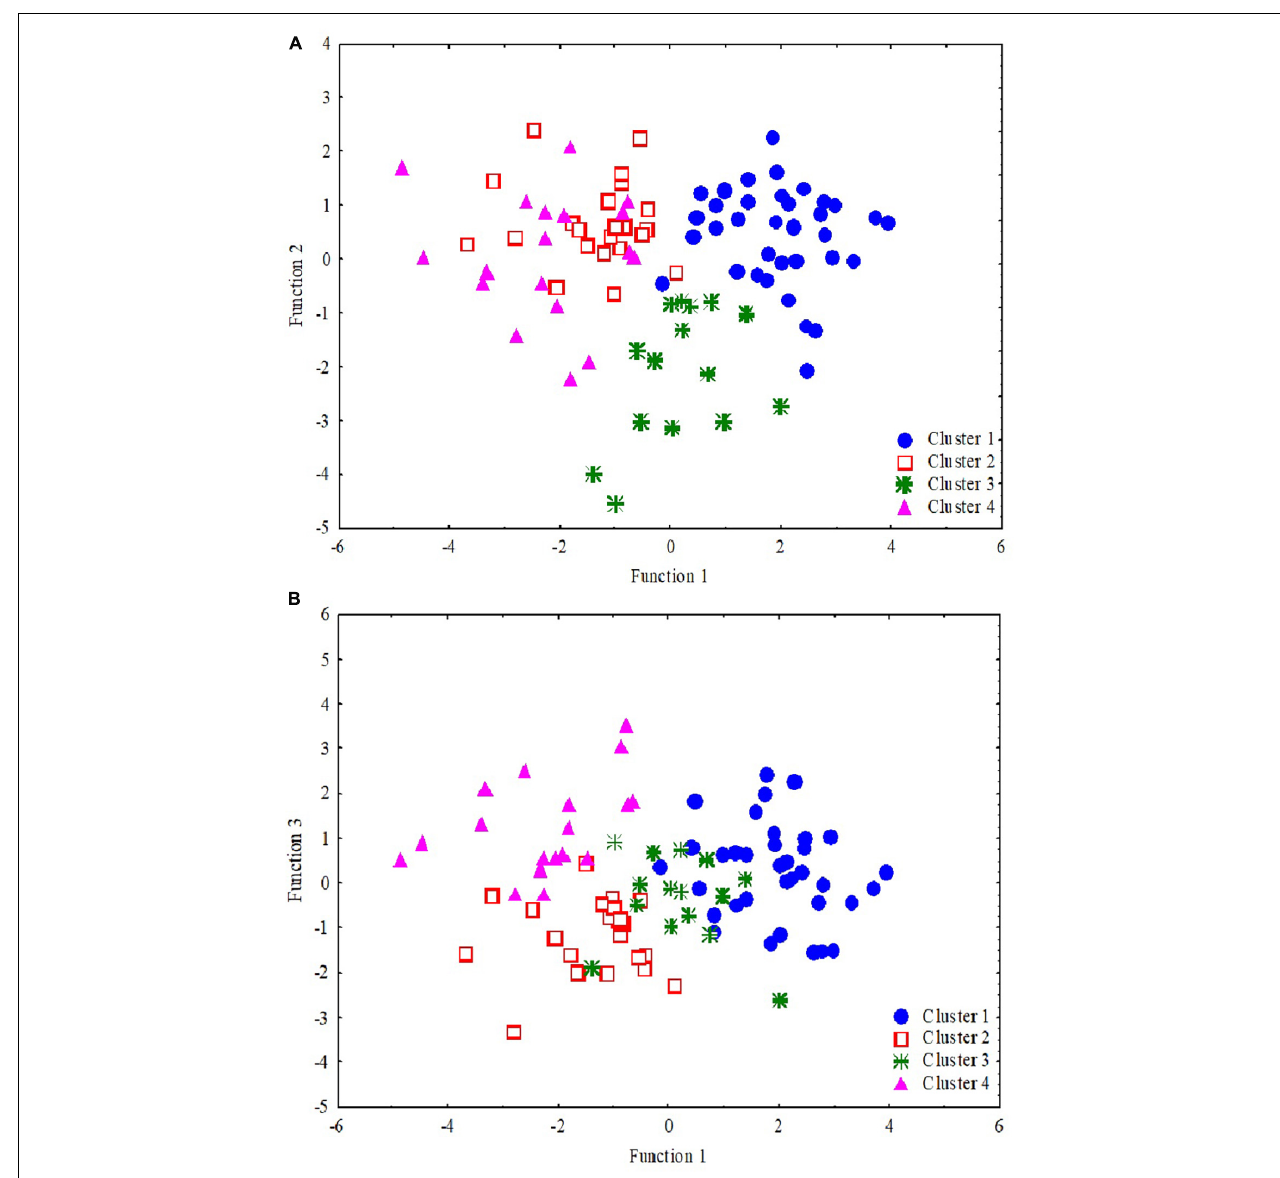
FIGURE 4 | Scatterplot of the discriminant functions. Each data point represents a single participant where cluster 1 (blue dots, n = 35), cluster 2 (red empty square, n = 22), cluster 3 (green star, n = 15), and cluster 4 (pink triangle, n = 18). The two plots depict clustering and separating of four clusters using three factors (of the 10 variables). While (A) shows that the clusters 1 and 3 are separated clearly by functions 1 and 2, (B) shows that clusters 2 and 4 separate very clearly by functions 1 and